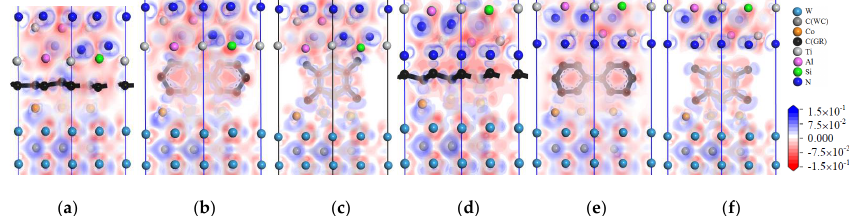
Figure 13. Charge-density difference image of the interface models with intrinsic graphene doping in the coating/matrix interface: ( a ) TiAlSiN Si /msGR/WC-Co; ( b ) TiAlSiN Si /acGR/WC-Co; ( c ) TiAlSiN Si /zzGR/WC-Co; ( d ) TiAlSiN N /msGR/WC-Co; ( e ) TiAlSiN N /acGR/WC-Co; ( f ) TiAlSiN N /zzGR/WC-Co.